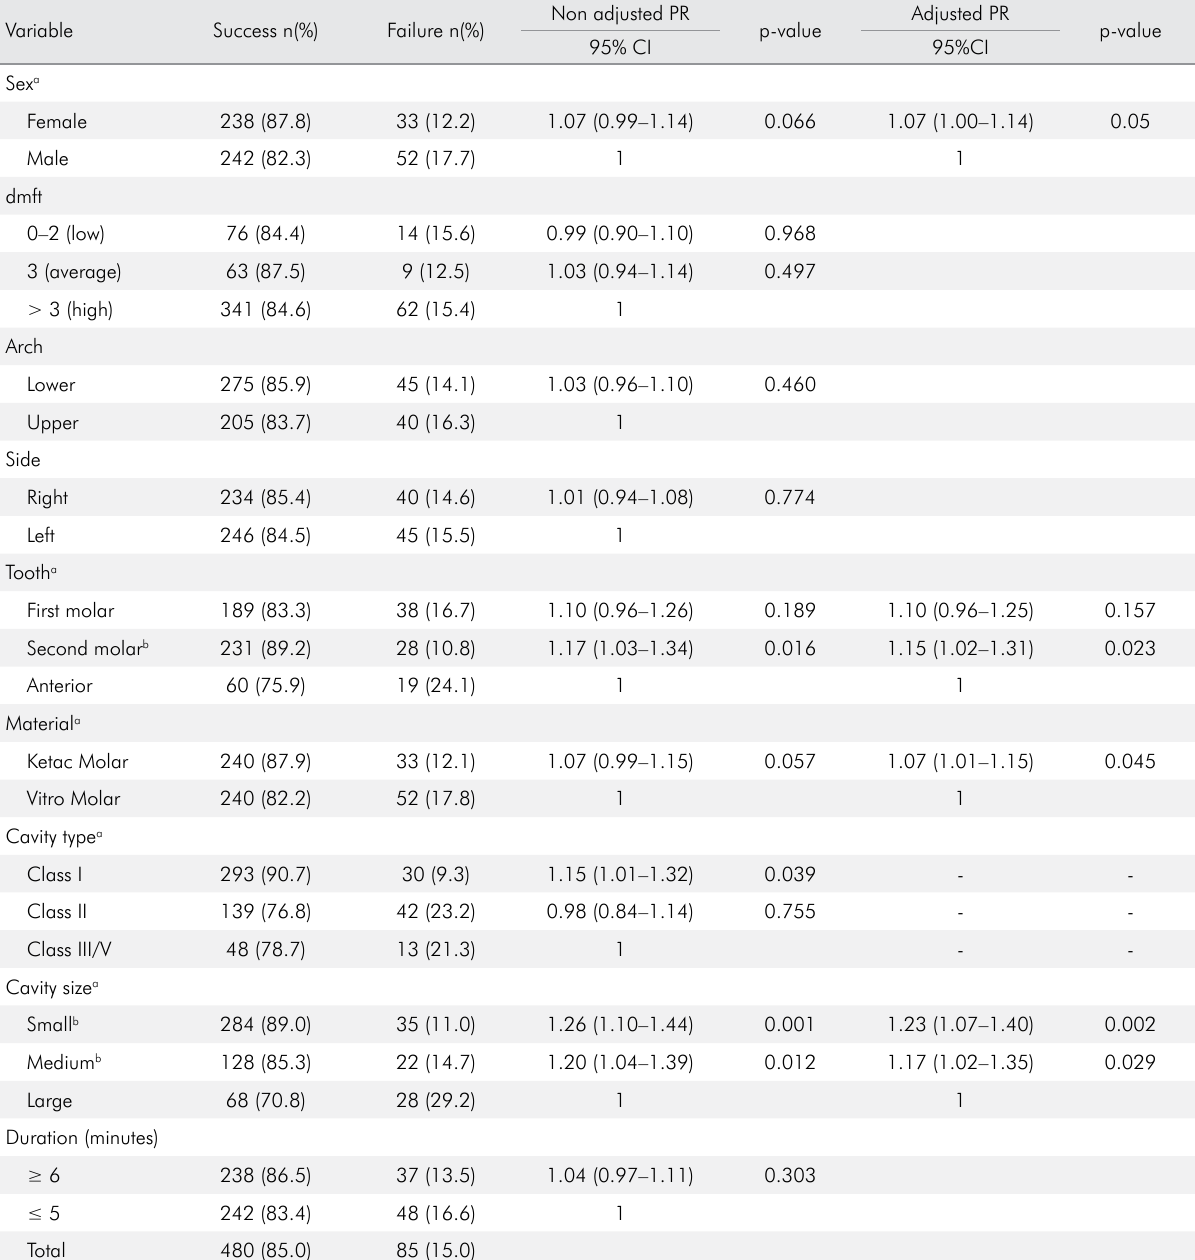
Table 2. Factors associated with the survival of restorations after six